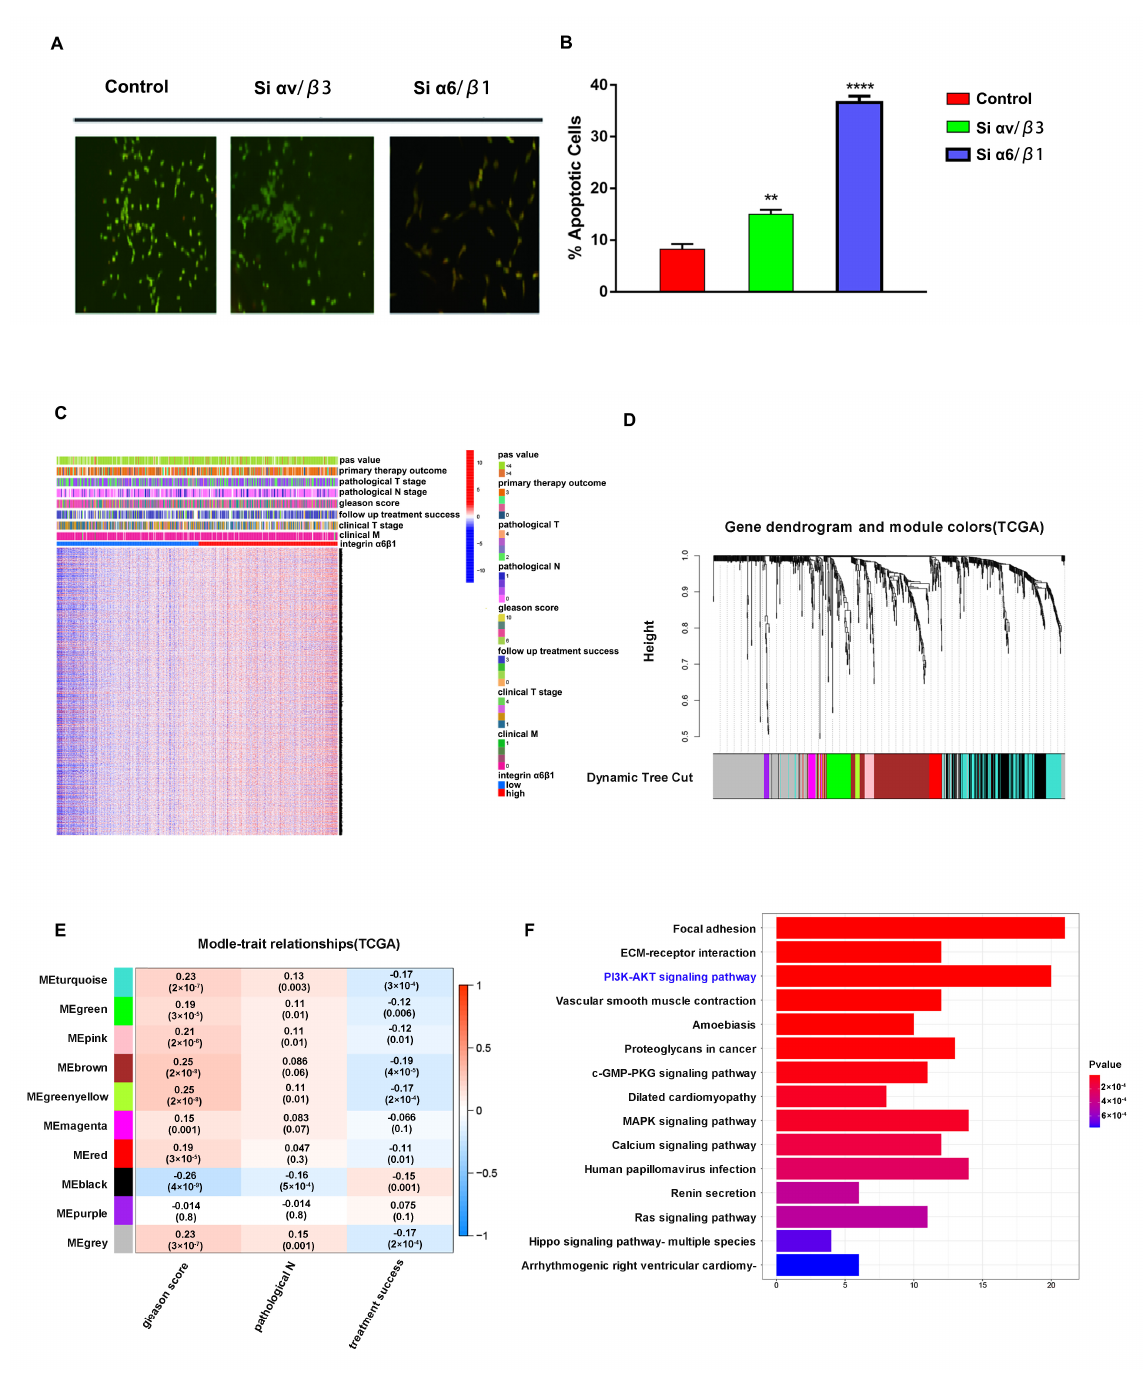
Figure 4. ( A , B ): AO/EB double fluorescent staining detected the apoptosis of C4-2 cells in the α v β 3 knockdown group, α 6 β 1 knockdown group and 5% glucose solution group. ( C ): Heatmap of differential gene expression of integrin high- α 6 β 1 group and integrin low- α 6 β 1 group according to TCGA patients. ( D , E ): WGCNA analysis was performed to identify similar gene modules in different genes and their correlation with clinical traits (Gleason score, pathological N stage, etc.). ( F ): KEGG enrichment analysis was performed for gene modules (MEgreenyellow and MEbrown). (** and **** stand for p value < 0.01 and 0.0001,